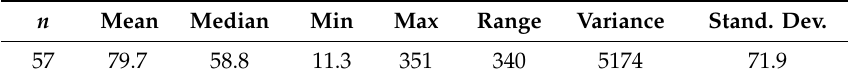
Table 4. Basic statistics for all mercury results obtained for canned tuna produced in di ff erent countries, including Poland ( n = 57) ( µ g /